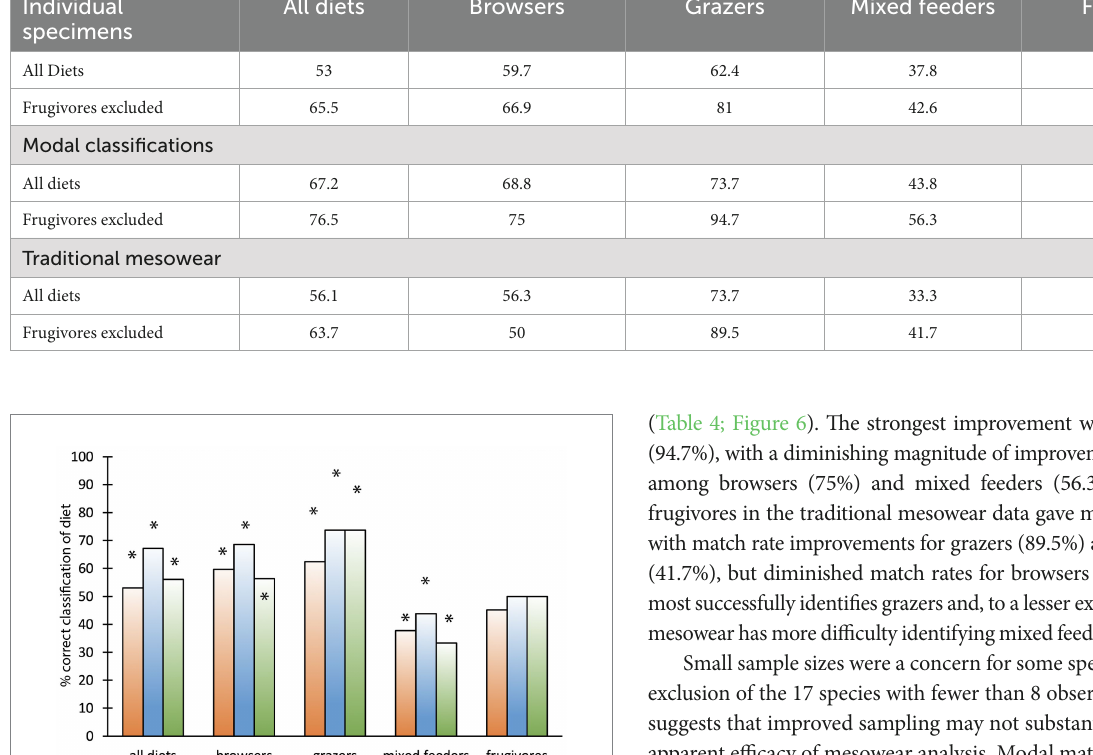
TABLE 4 Jackknifed percentages of correct a priori and a posteriori matches based on DFAs with high-quality data. Individual specimens